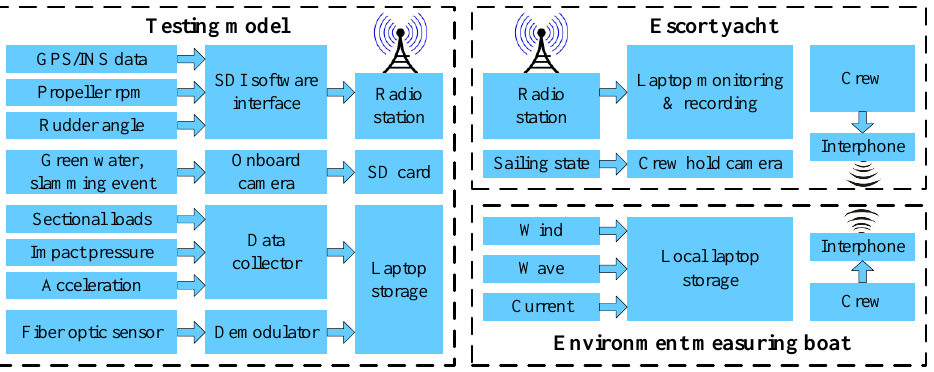
Figure 23. Framework of the telemetry system.